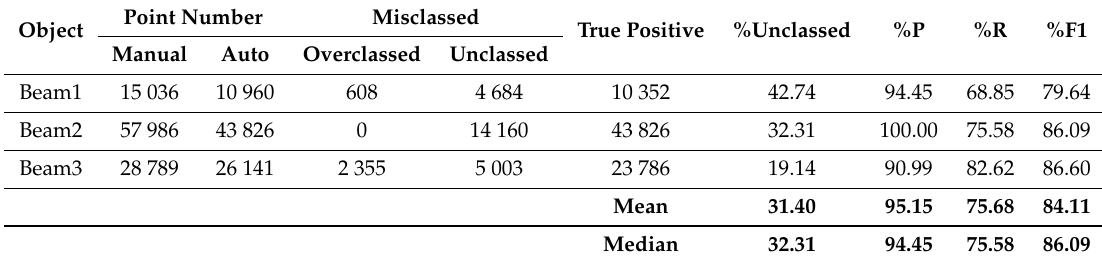
Table 7. Quantitative analysis on the results of step 2 for the detection and classification of beams. %P is precision, %R is recall, and %F1 is the normalized F1